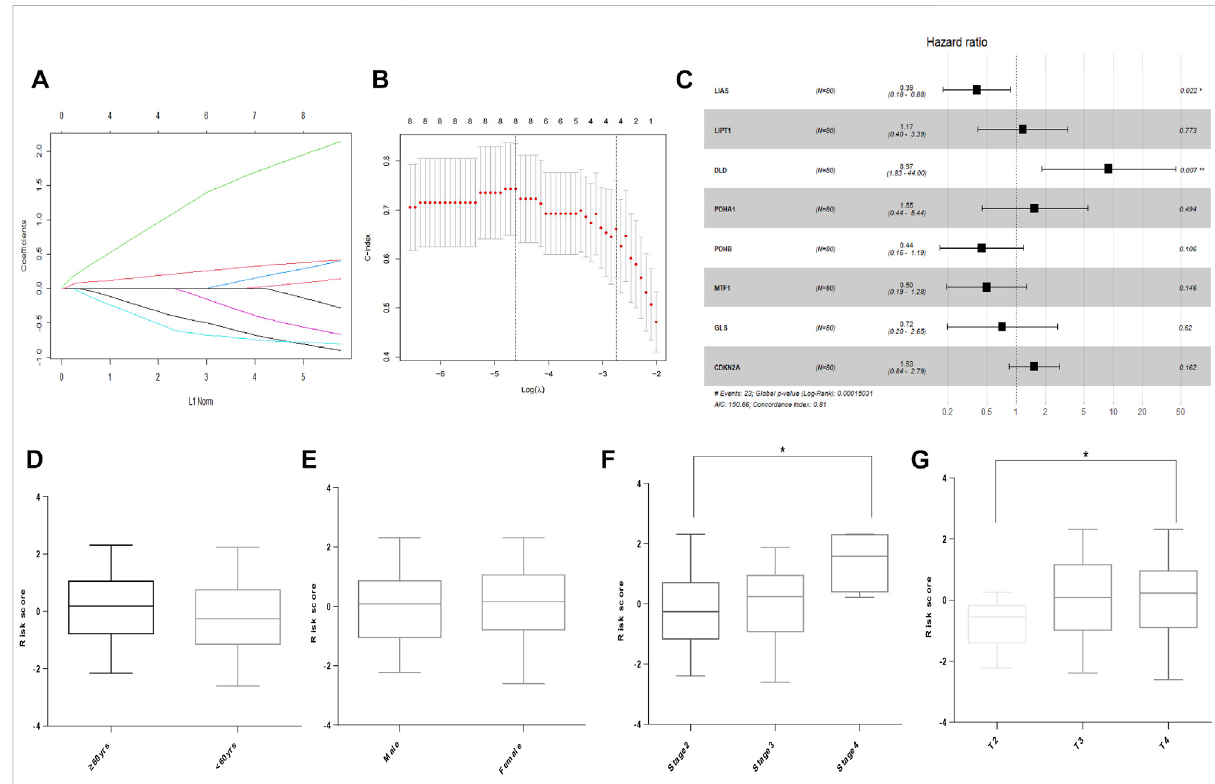
FIGURE 2 BuildingoftheprognosticsignatureinUVM. (A) CRGpro fi lesbasedonLASSOcoef fi cients. (B) LASSOcoef fi cientvaluesoftheCRGsinUVM.The vertical dashed lines are the optimal log λ values. (C) Hazard ratio, con fi dence interval, and p -value of the eight prognostic CRGs in univariate Cox regression. (D) Risk score in patients by age using a cutoff of 60 years. (E) Risk score in men and women. (F) Risk score in patients with different pathologic stages. (G) Risk score of patients with different T stages. * denotes p <